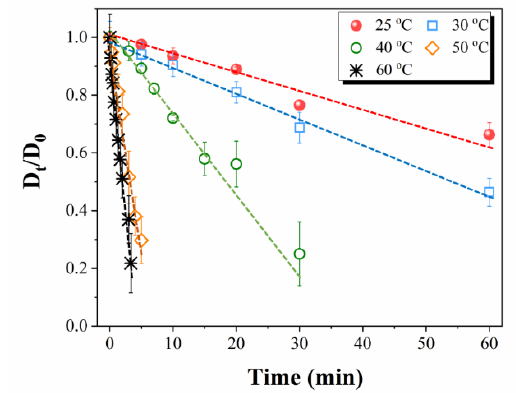
Figure 4. Relative diameter of flax fiber in [EMIM][OAc] as a function of time at various temperatures. Dashed lines are linear approximations.